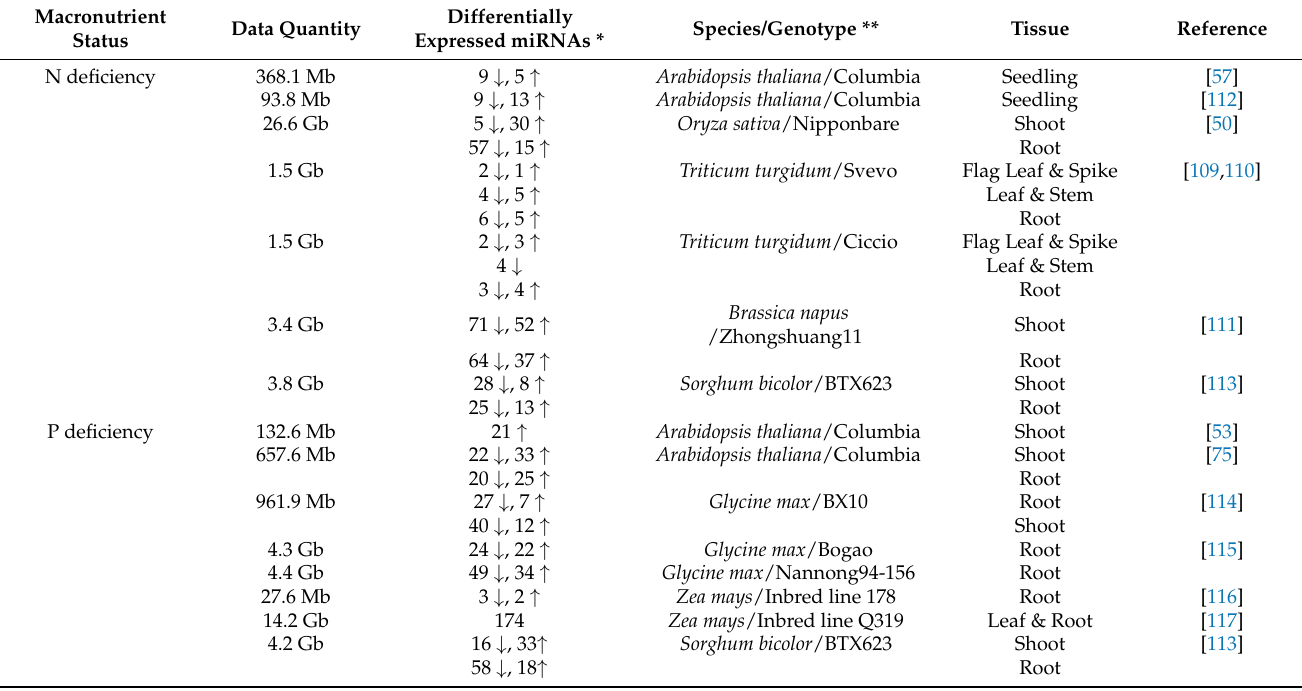
Table 1. Summary for large-scale identification of macronutrient-stress-responsive miRNAs via high-throughput sequencing. Macronutrient